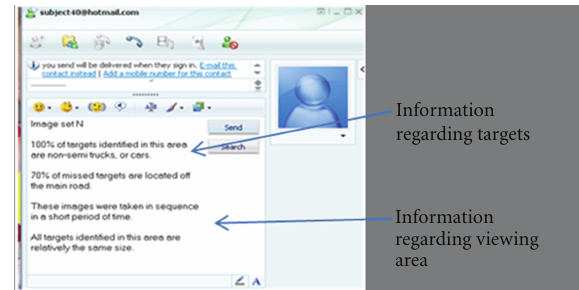
Figure 3: Message